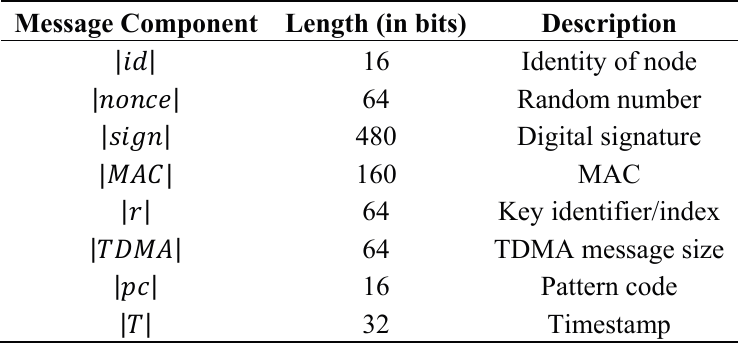
Table 5. Assumption for the length of message components.